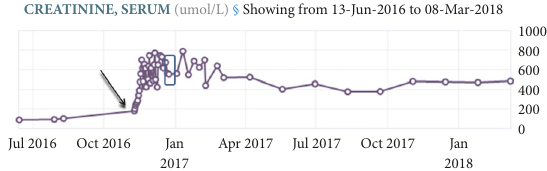
Figure 1: Serum creatinine trend. Serum creatinine at baseline was 91 umol/L (reference range: 40-100 umol/L). It increased to 177 umol/L on day of admission (arrow) to peak of 800 umol/L during admission. On day of discharge, serum creatinine was 554 umol/L (box). Dabigatran was started two years before this